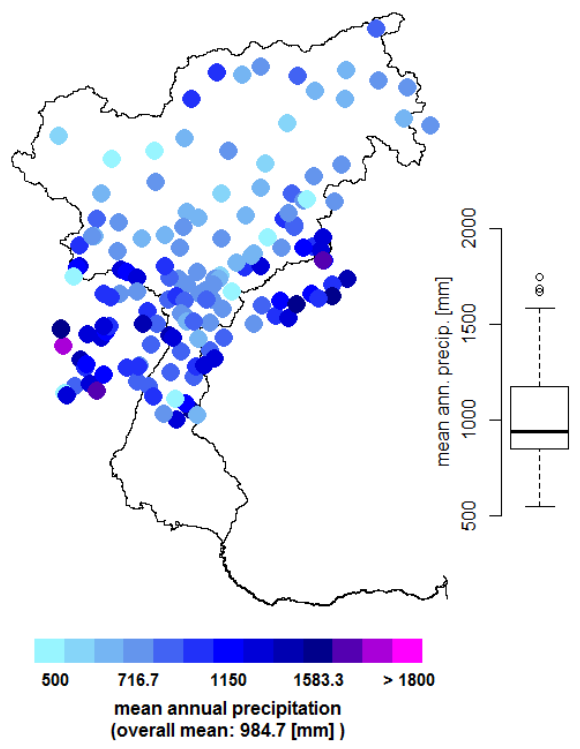
Figure 2. Mean annual precipitation sums for the observation stations.